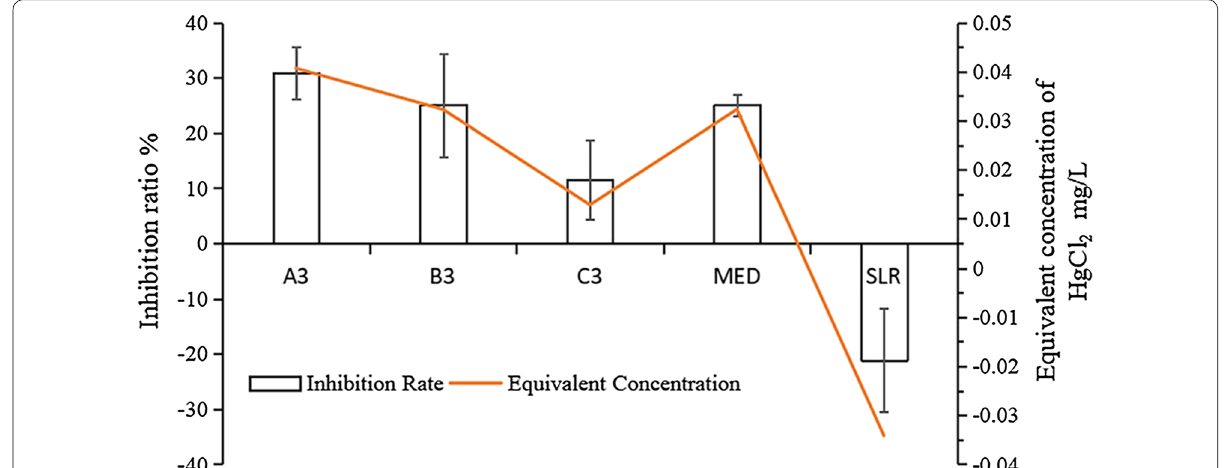
Fig. 7 The luminous inhibition ratio and the equivalent concentration of HgCl 2 in different sediments. The inhibition rates and equivalent concen- trations of HgCl 2 were shown in the figure. The inhibition rates were calculated by the negative control. The equivalent concentrations of HgCl 2 were calculated according to the standard curve. The symbol A3 (B3, C3): the sampling site near the leak point; MED: control site in Jiaozhou Bay; SLR: control site outside of Jiaozhou